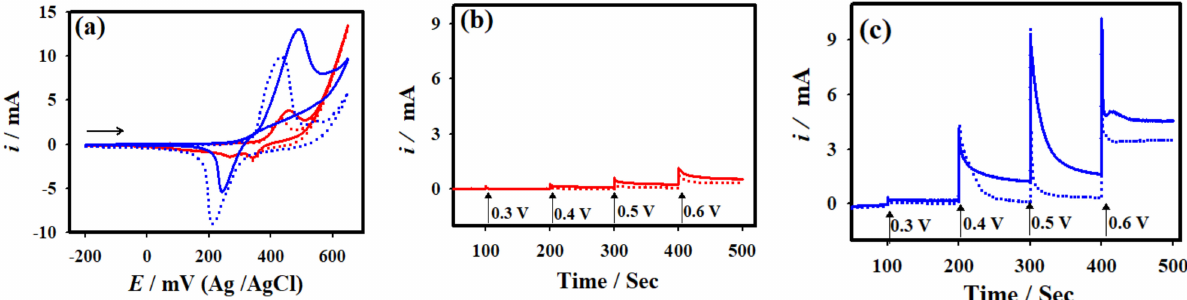
Figure 2. ( a ) CV curves of the bare NF (red curve), and NC-NiS@NS-NiS|NF (blue curve) measured in the absence (dotted cuve) and the presence (solid curve) 10.0 mM glucose + 1.0 M KOH. Chronoamperometric i-t results of ( b ) bare NF (red curve), and ( c ) modified with NC-NiS@NS-NiS|NF (blue curve) at different constant applied